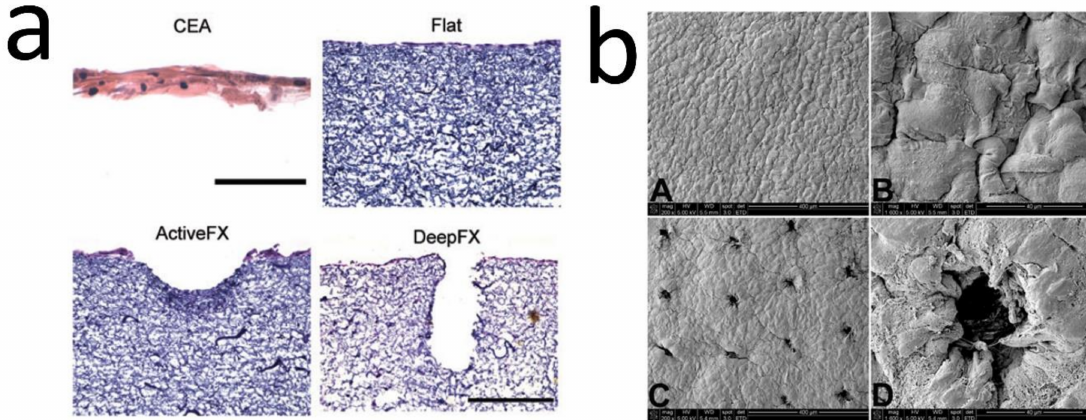
Figure 6. ( a ) H&E of CEAs (at in vitro culture day 20), and flat electrospun COL dermal templates (5 days after seeding with human dermal Fs), ActiveFX & DeepFX (laser-treated groups). CEA and dermal template scale bar = 100 and 200 µ m. Photo reused with permission [33] © 2020 Tissue Engineering: Part A, Mary Ann Liebert, Inc. ( b ) SEM of HFs-seeded dermal components before (flat, A , B ) and after (ridged, C , D ) laser treatment, before seeding HKs. Photo used with permission